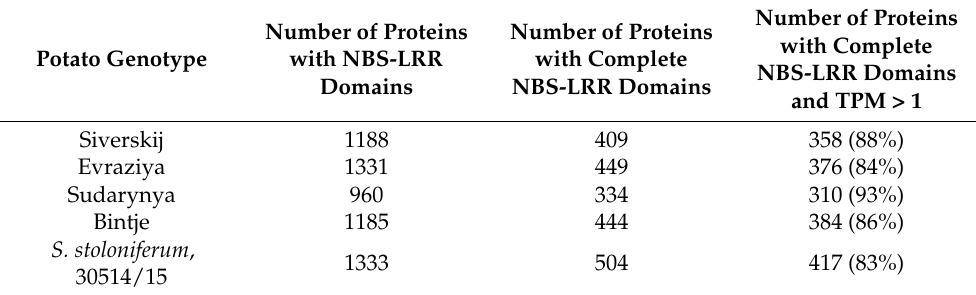
Table 2. Proteins encoded by de novo-assembled potato transcriptomes and containing predicted NBS-LRR domains.